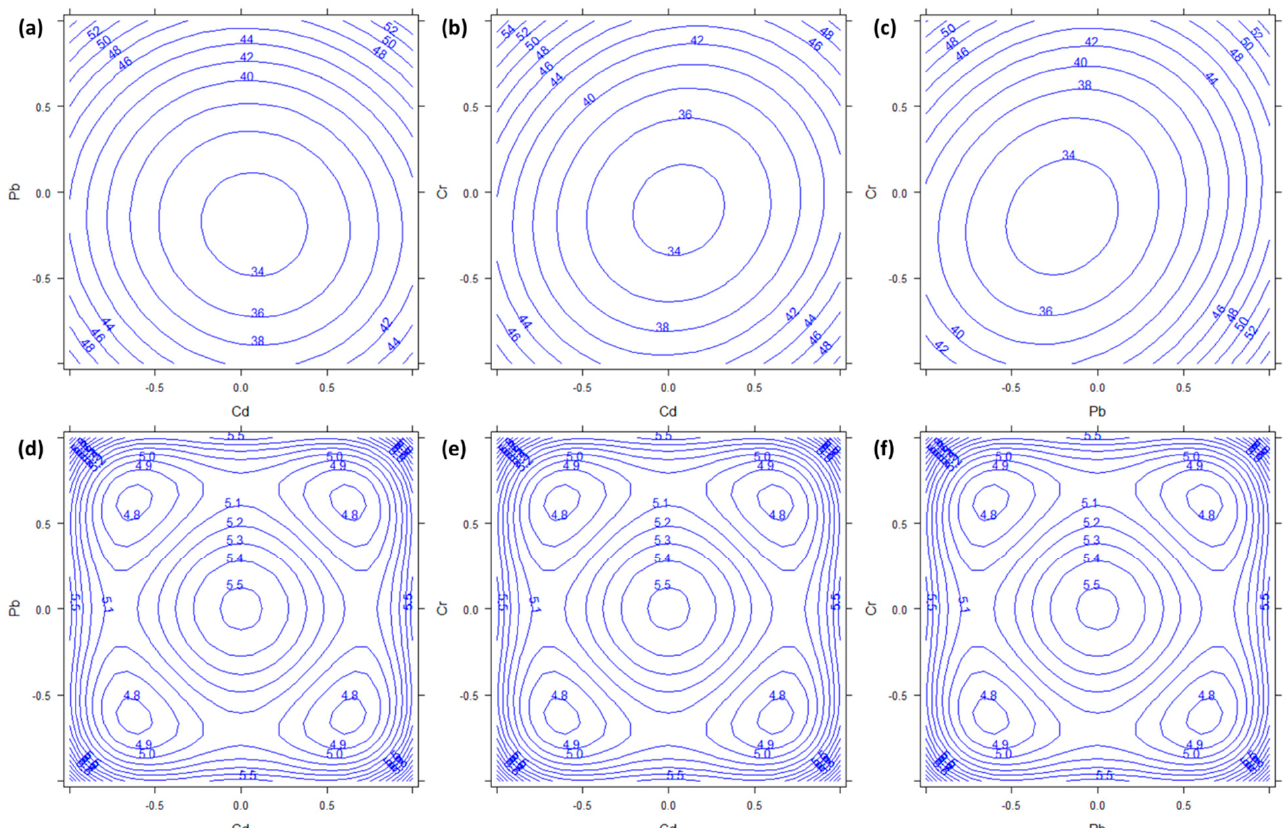
Figure 5. Response surfaces and semiamplitudes of the 95% confidence intervals for Zn dependent variable. Factors are: ( a , d ) Pb vs. Cd; ( b , e ) Cd vs. Cr; ( c , f ) Pb vs. Cr. The third factor, not represented in each plot, has always been kept constant to the 0 level.